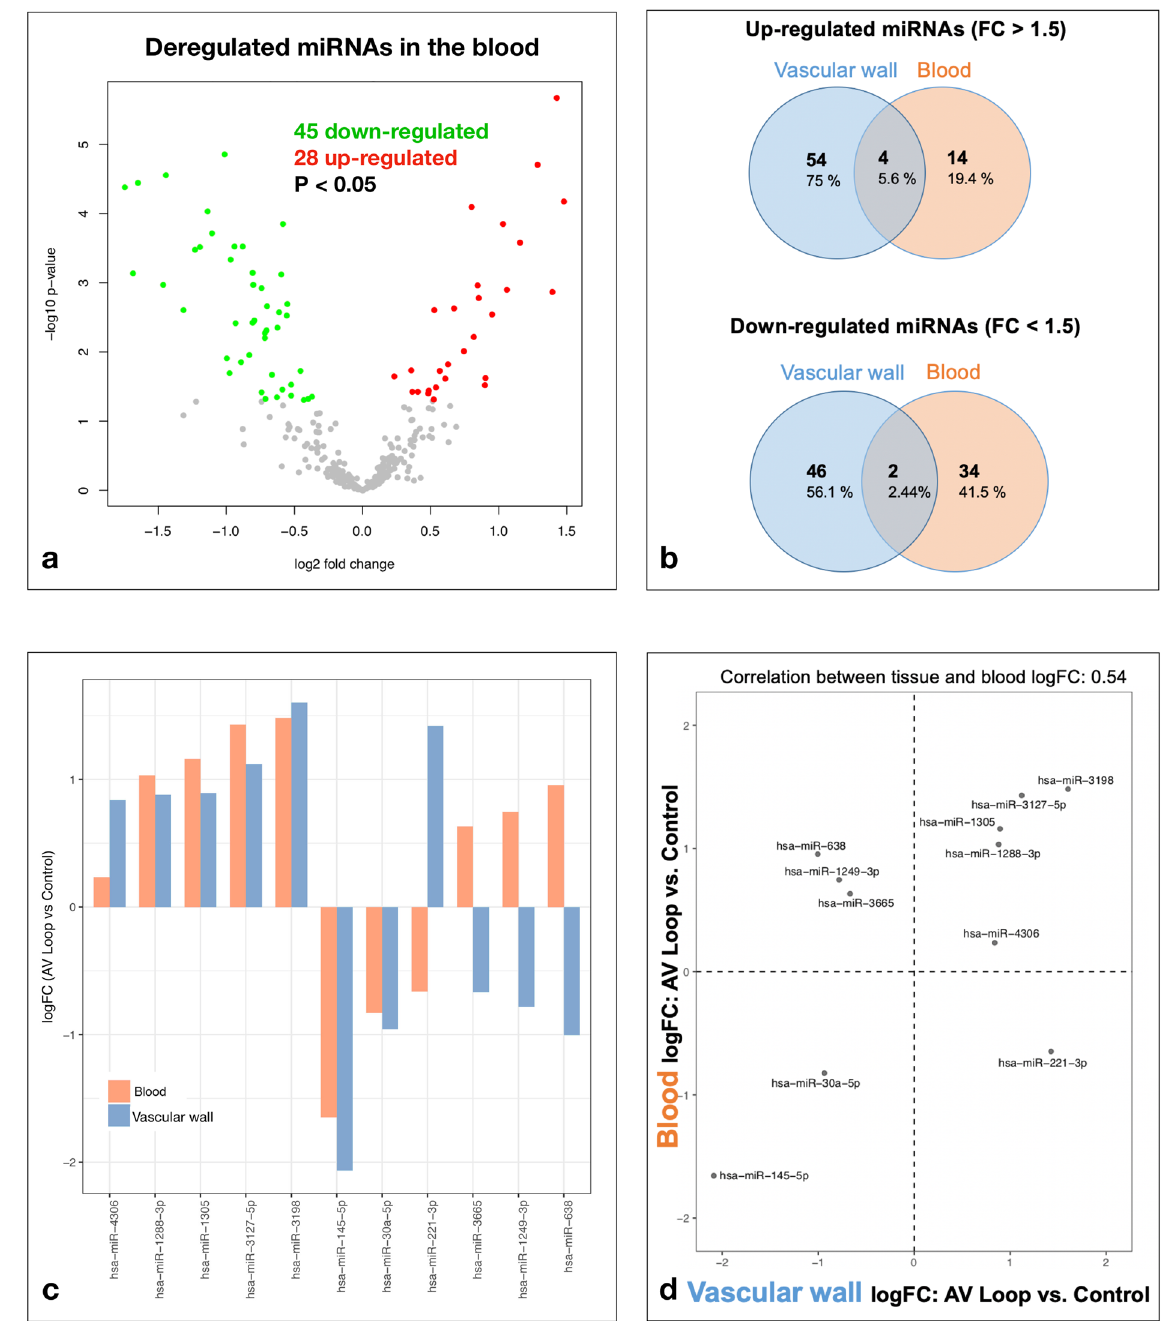
Figure 3. ( a ) Volcano plot showing the deregulated miRNAs in the blood on postoperative day (POD) 9 after arteriovenous (AV) loop placement. Colored dots represent significantly deregulated miRNAs (p < 0.05) with red dots representing up-regulated and green dots representing down-regulated miRNAs. ( b ) Venn diagram showing the absolute and relative count of miRNAs up- and down-regulated by fold-change (FC) > 1.5, resp. < 1.5 in the peripheral blood and the vascular wall of AV loops (POD 10 after loop placement). The complete miRNA expression profiles in vascular AV loop tissue were previously published 10 . ( c,d ) Correlation between miRNA expression profiles in blood and vascular tissue reveals 5 concordantly up-regulated miRNAs ( d , upper right quadrant), 2 concordantly down-regulated miRNAs ( d, lower left quadrant), and 4 discordantly deregulated miRNAs ( d , upper left and lower right